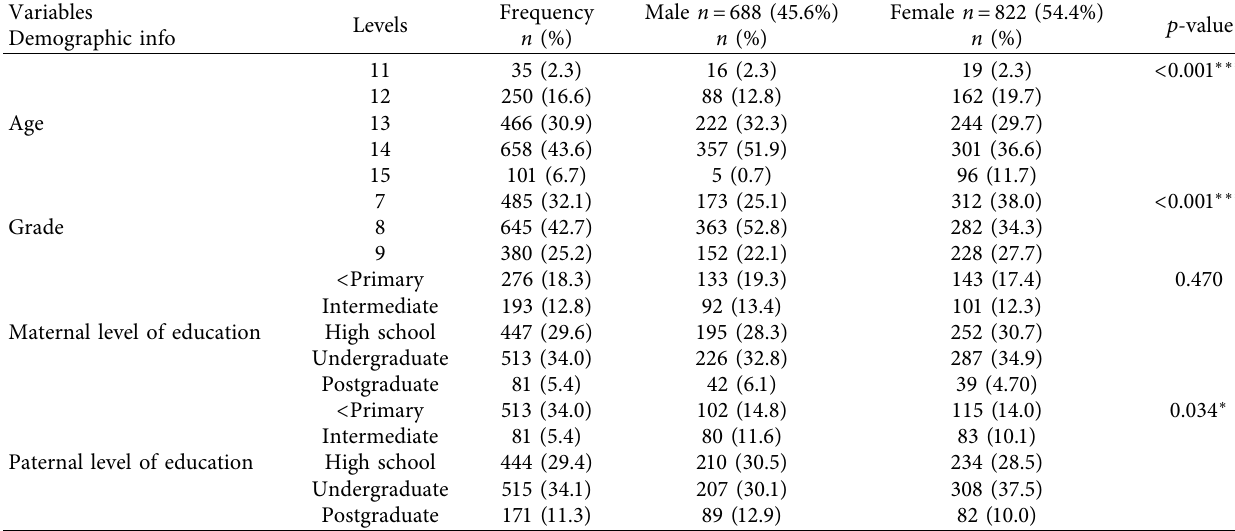
Table 1: Sociodemographic characteristics among 1500 adolescents in the KSA by gender.